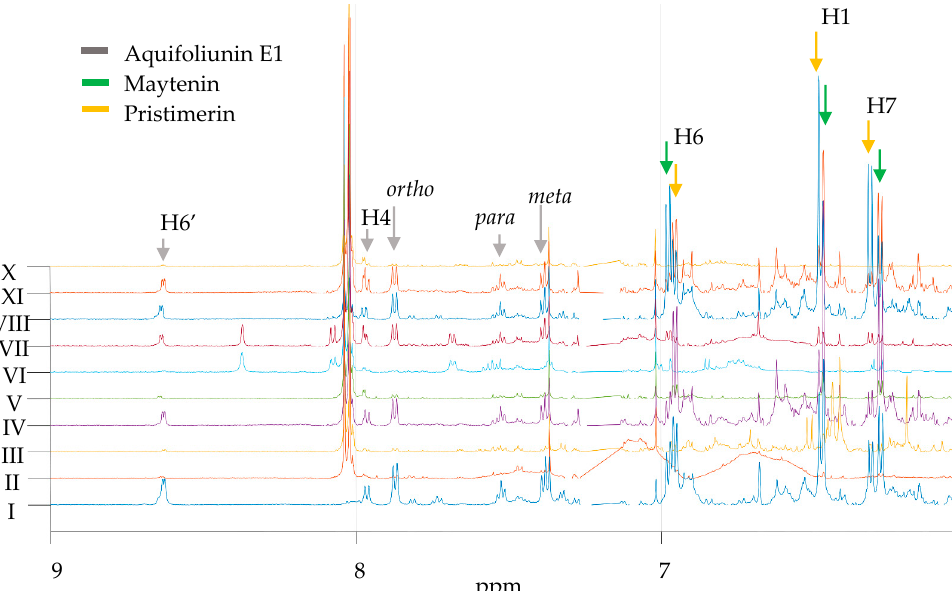
Figure 3. 1 H-NMR spectra of PAVARINI I-X raw extracts (hexane–ethyl acetate 8:2) and the detection of SPA aquifoliunin E1 signals at δ 8.62 ( dd , J 4.7 Hz, 1.8, 1H, H-6 ′ ), δ 7.96 ( dd , J 7.8; 1.8 Hz, 1H, H-4 ′ ),